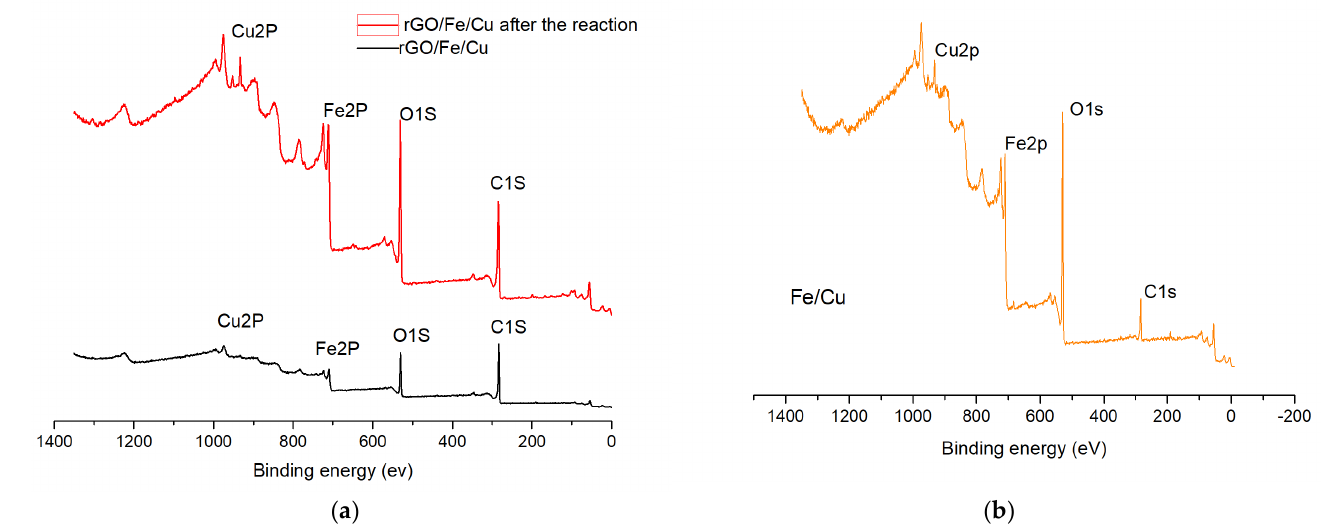
Materials 2021 , 14 , x FOR PEER REVIEW